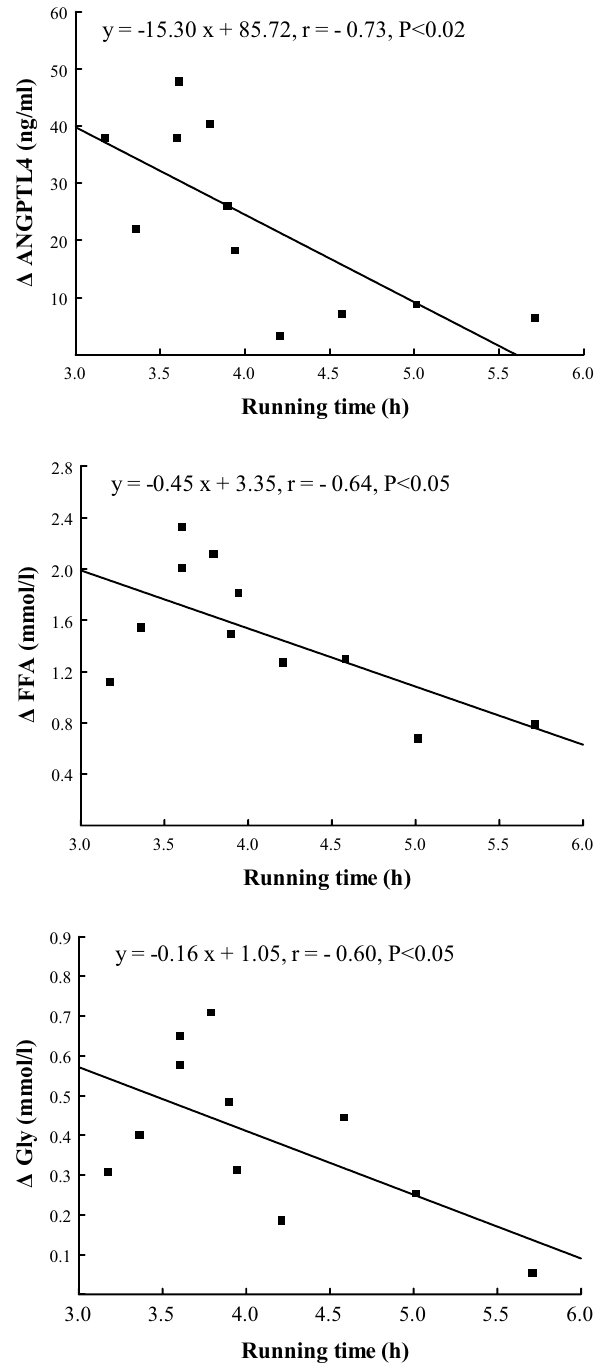
Figure 5. The relationships between exercise-induced changes in plasma concentration of angiopoietin-like protein 4 (ANGPTL4), free fatty acids (FFA) and glycerol (Gly) and running times obtained by